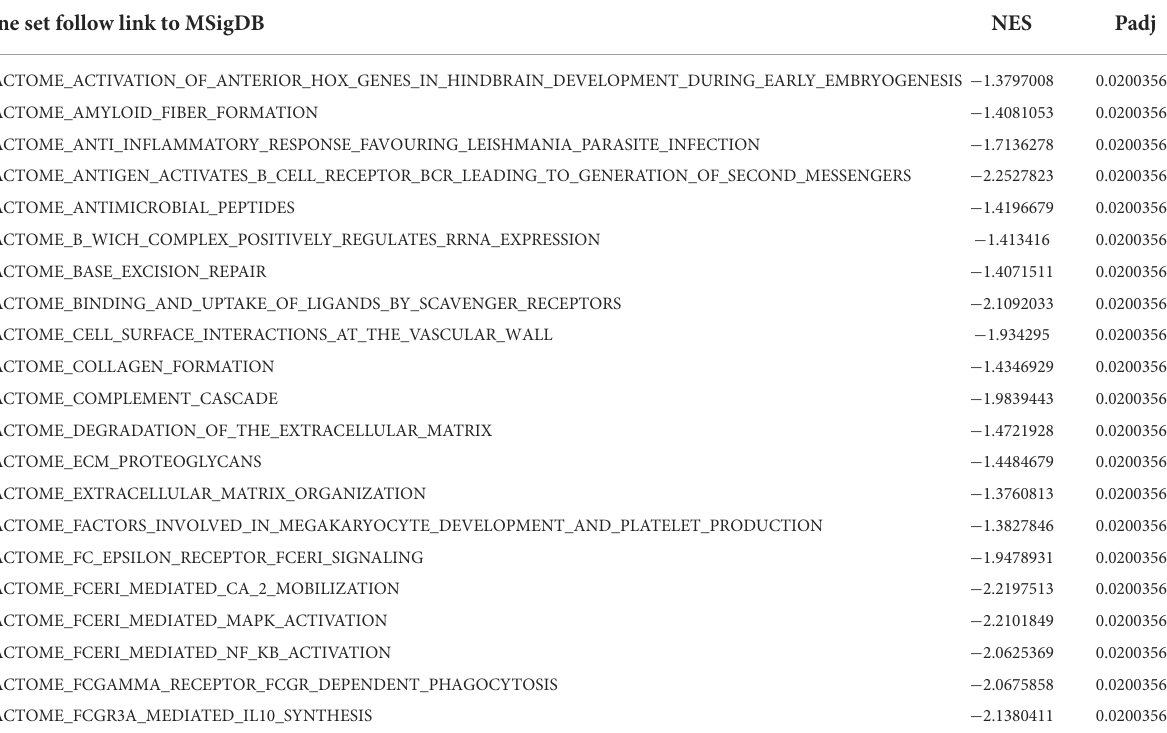
TABLE 3 The top 20 gene sets of COVID-19 patients vs. normal controls in gene set enrichment analysis. Gene set follow link to